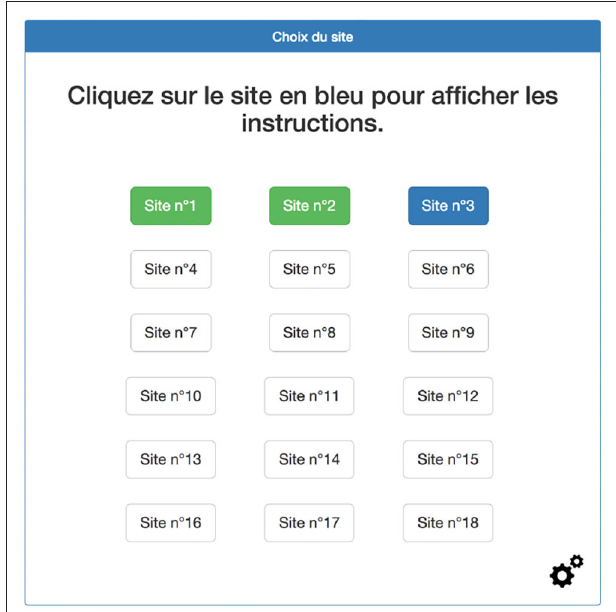
FIGURE 2 | Example of screen on which participants had to click the next item to get the instruction. The white button indicates a website not yet visited, the green button a website already visited, and the blue button the next website to visit. Only the blue button was